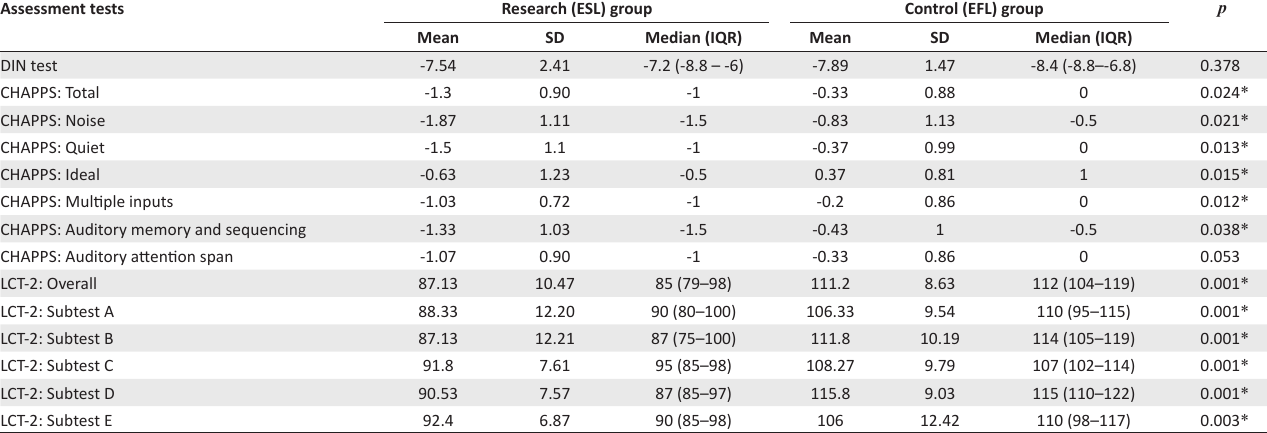
TABLE 2: Overall outcome of the digits-n-noise test, children’s auditory processing performance scale and listening comprehension test-2. Assessment